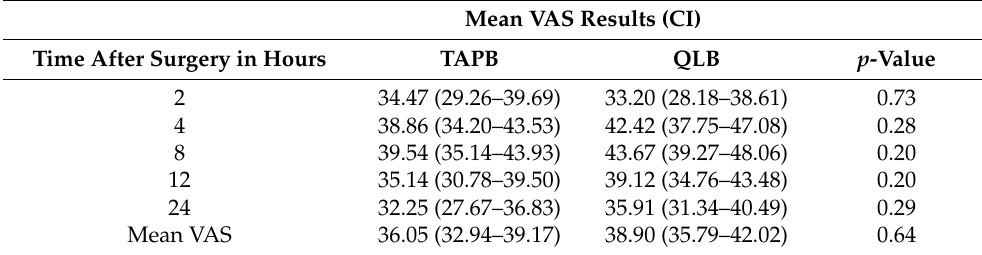
Table 3. Postoperative pain severity during the first 24 after the surgery.